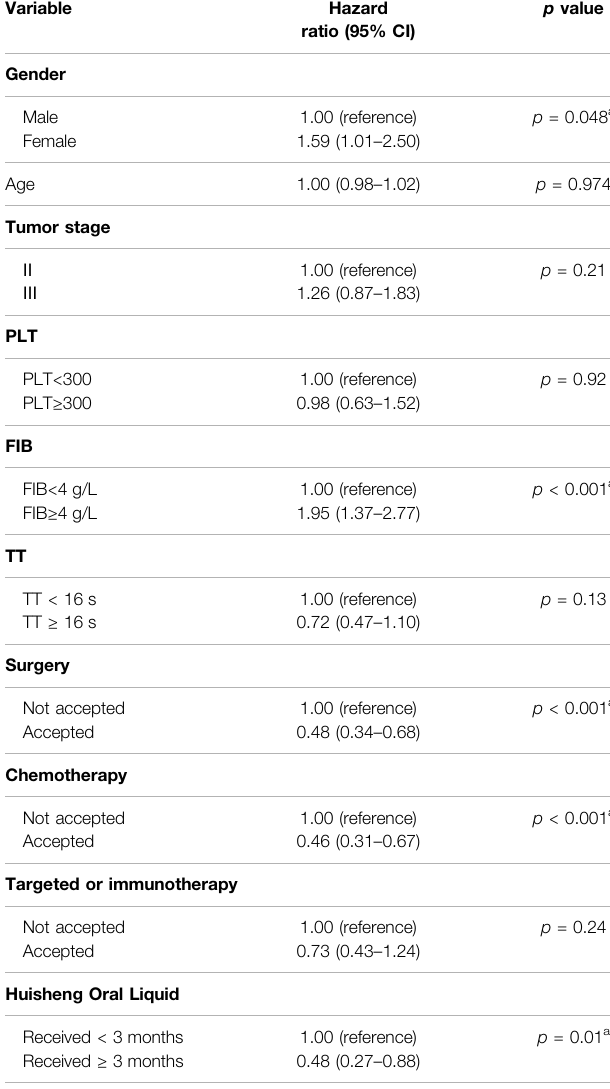
TABLE 7 | Multi-variable Cox regression